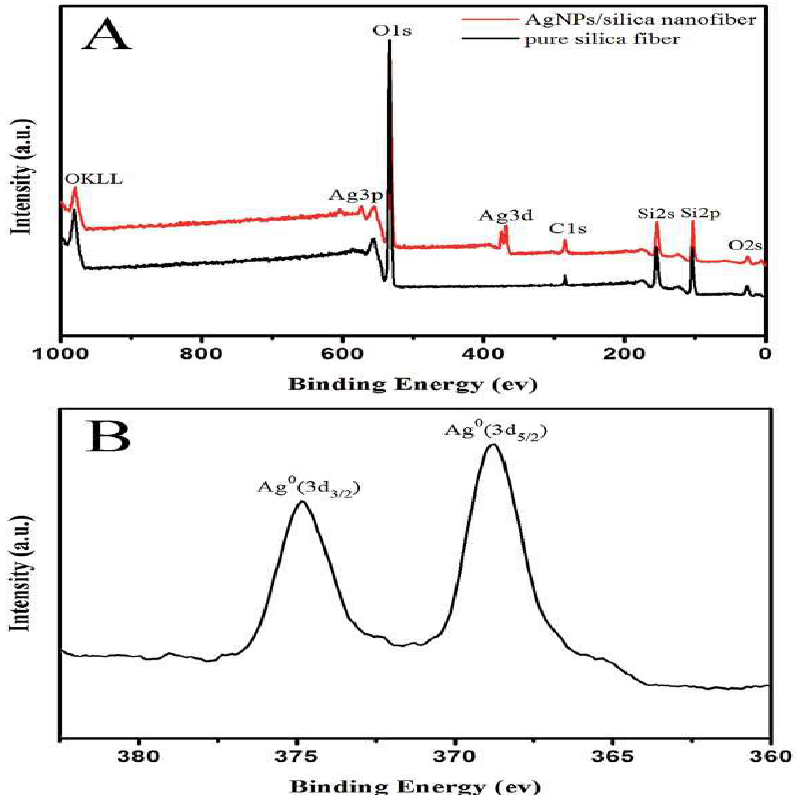
Figure 12. XPS spectra of composite nanofiber: ( A ) full XPS spectrum of AgNPs/silica nanofiber and pure silica nanofiber, ( B ) Ag3d of AgNPs/silica nanofiber. Reproduced with permission [169]. Copyright 2016, Royal Society of Chemistry.